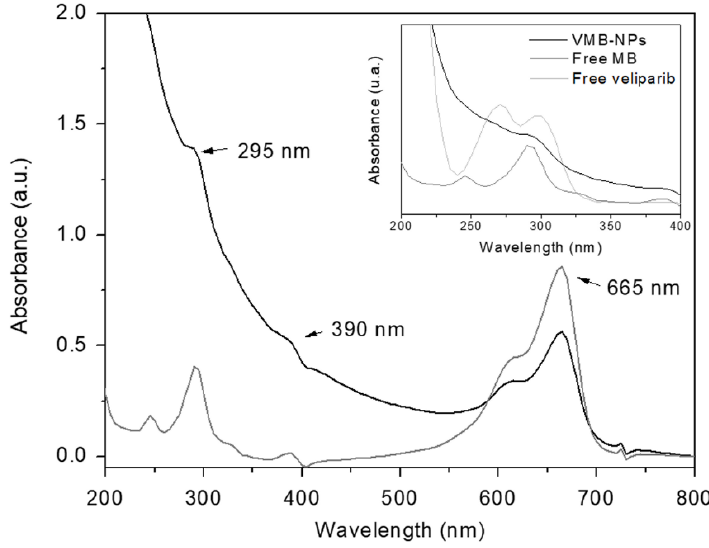
Figure 3. UV-Vis spectra of VMB-NPs (black) and free methylene blue (MB) (dark gray). Insert: UV-Vis spectra of VMB-NPs (black), free MB (dark gray) and free veliparib (gray) at smaller wavelengths. UV-Vis spectra were also used to calculate the encapsulation efficiency of both